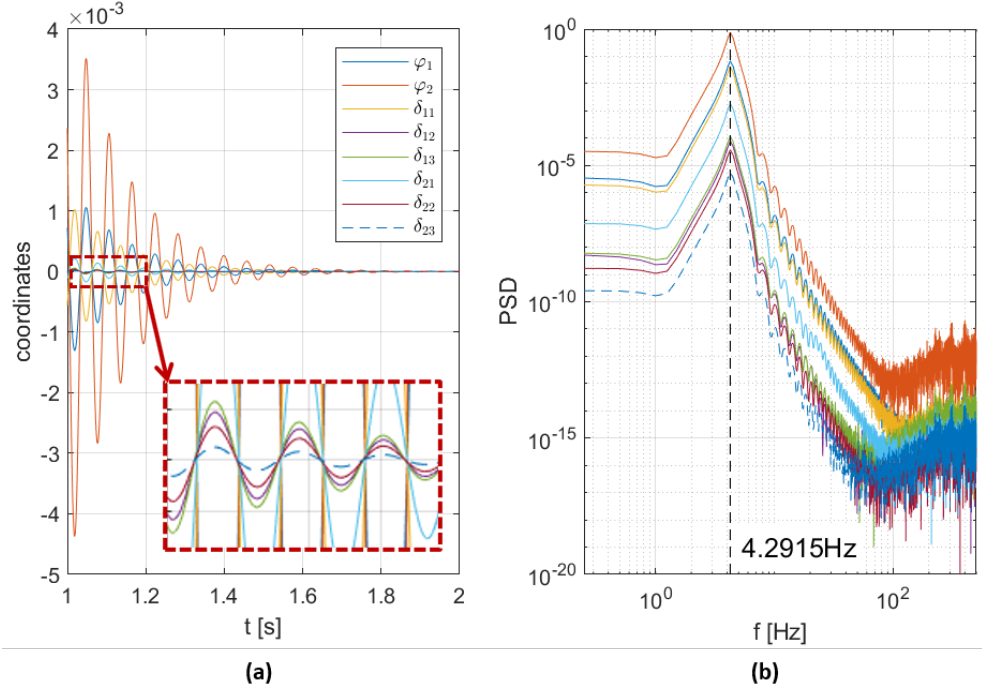
Figure 4. Natural motion: residual vibrations. ( a ) Coordinates of time behaviour; ( b ) power spectra density with significant Eigen frequency of 4.2915